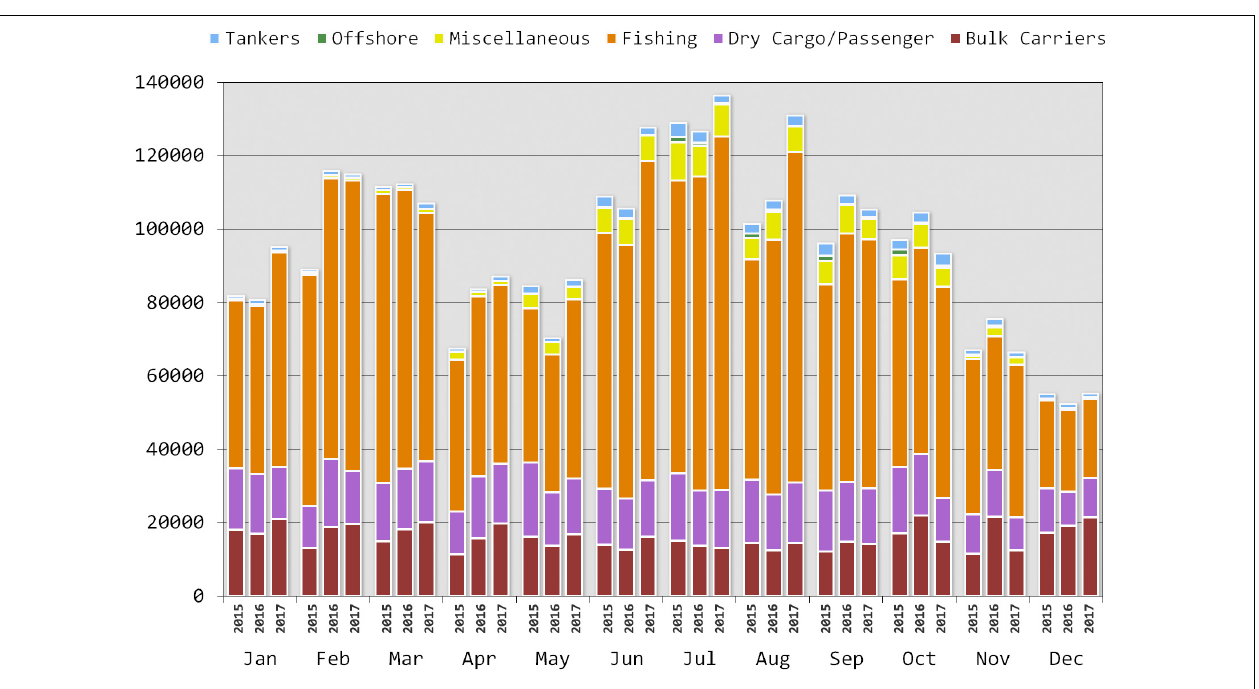
FIGURE 6 | Vessel hours of operation in the Bering Sea, by month and vessel class, in 2015, 2016, and